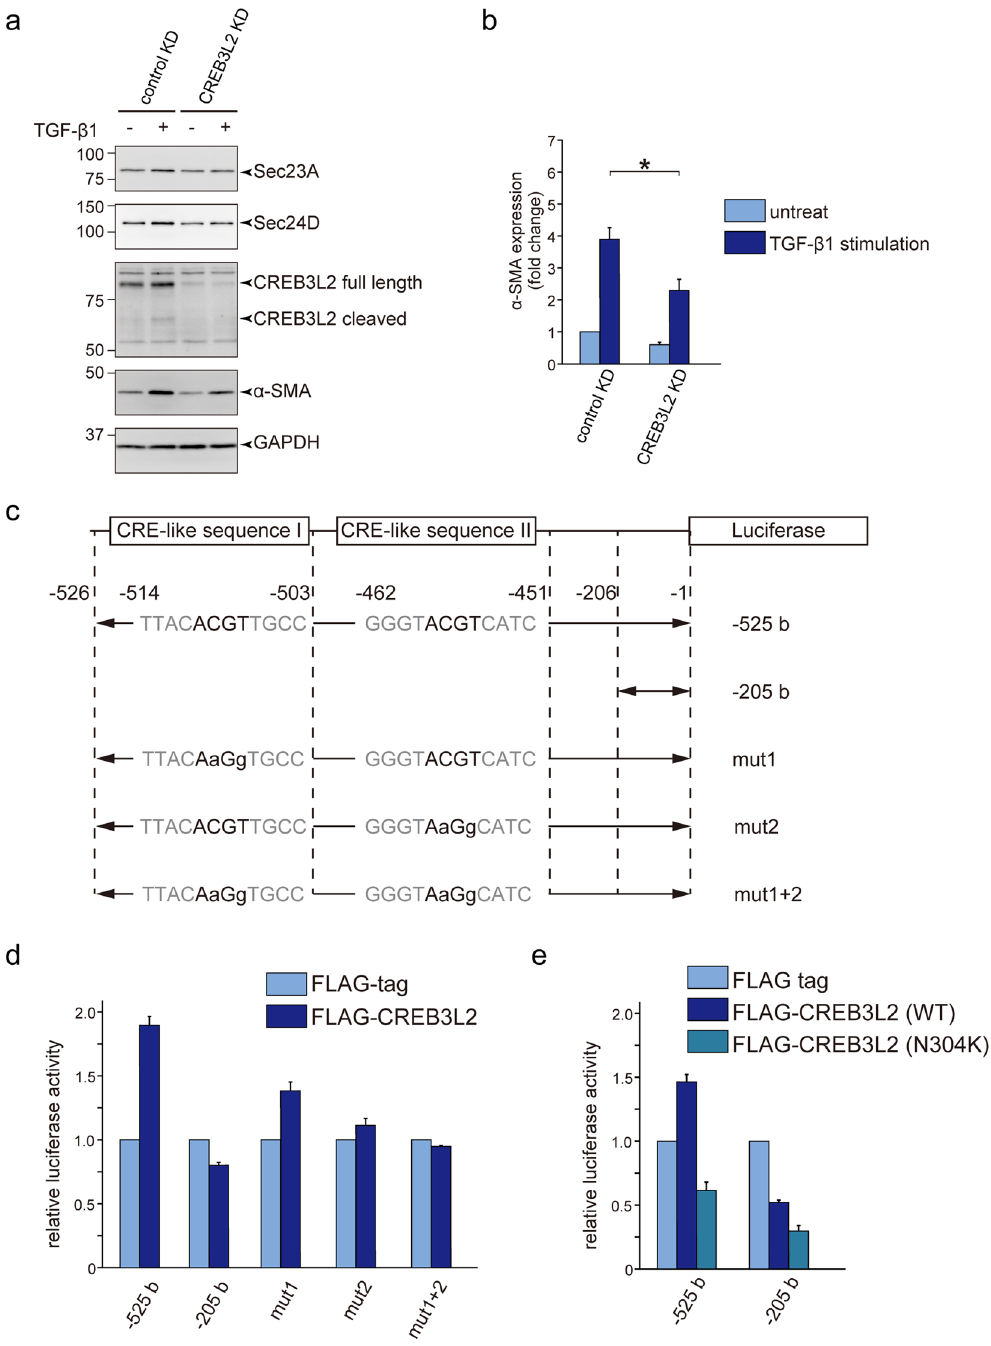
Figure 3. CREB3L2/BBF2H7 is involved in the activation of LX-2 cells by transcriptionally regulating Sec23A and Sec24D. ( a and b ) LX-2 cells transfected with the indicated siRNA(s) were cultured for 24 h in DMEM supplemented with 10% FBS. After starvation for 24 h with DMEM supplemented with 0.5% FBS, the cells were untreated or treated with 1 ng/ml TGF- β 1 and cultured for 3 days. Proteins were extracted and subjected to SDS-PAGE, followed by western blotting with anti-Sec23A, anti-Sec24D, anti-CREB3L2/BBF2H7, anti- α -SMA and anti-GAPDH antibodies. ( a ) Representative immunoblots. ( b ) Quantification of immunoblots ( n = 6). The band intensities of α -SMA were normalized to those of GAPDH. (c and d) Dual-luciferase reporter assay was performed with Sec24D promoter constructs attached to a luciferase gene and CREB3L2/BBF2H7 construct. ( c ) Schematic view of the reporter constructs. ( d and e ) Quantification of relative luciferase activity ( n = 3). Error bars represent mean ± SEM. * P < 0.05. Uncropped original blots were shown in Fig.